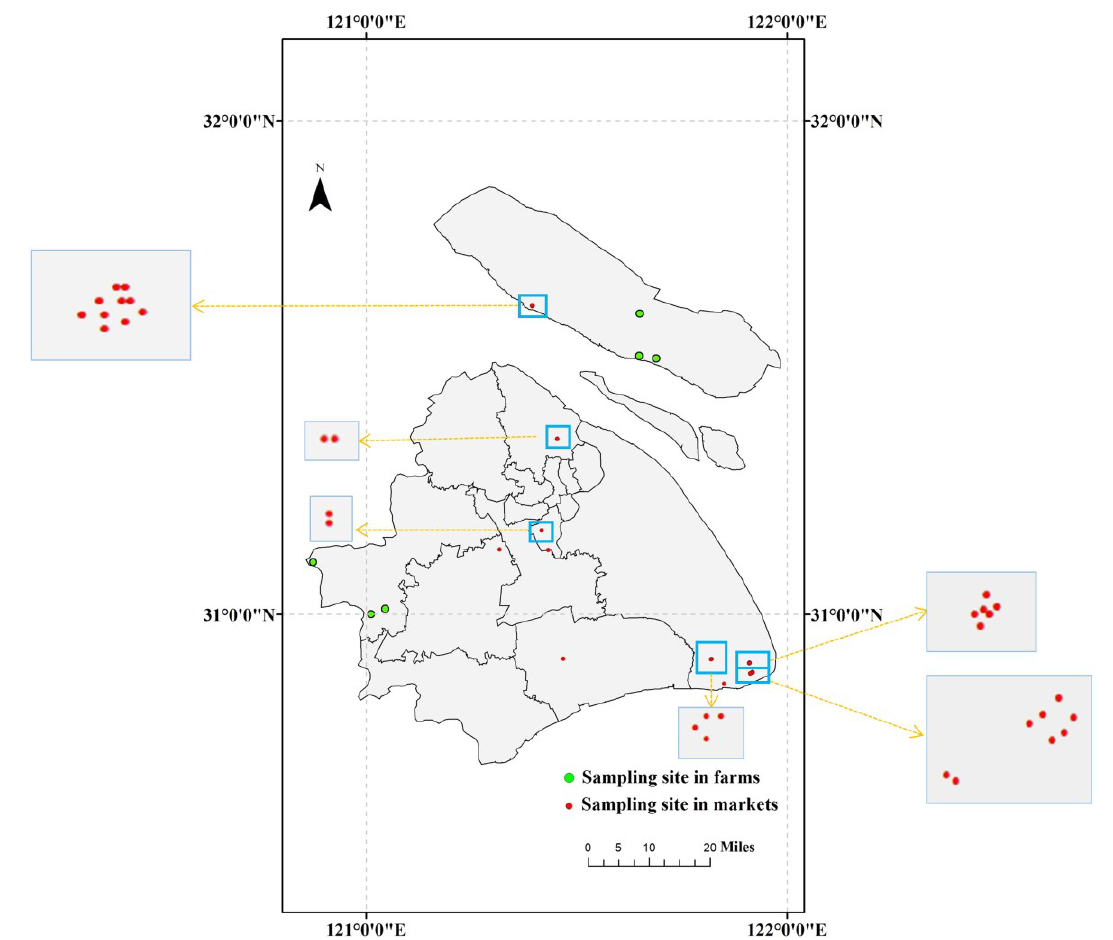
Figure 1. Crab sampling sites in Shanghai.